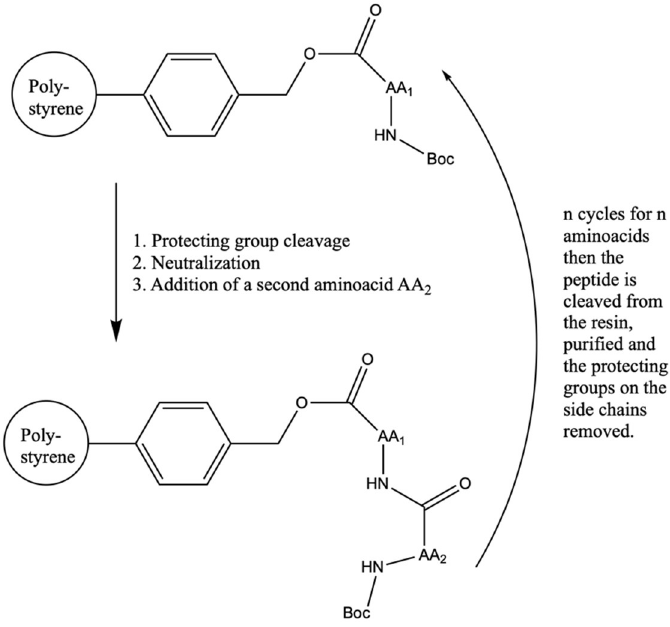
Figure 1. Merrifield peptide synthesis on a polystyrene support.